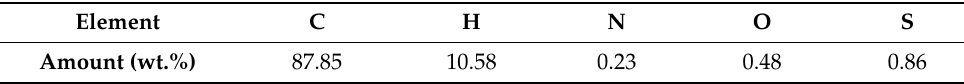
Table 1. Elemental composition of PP plastic.